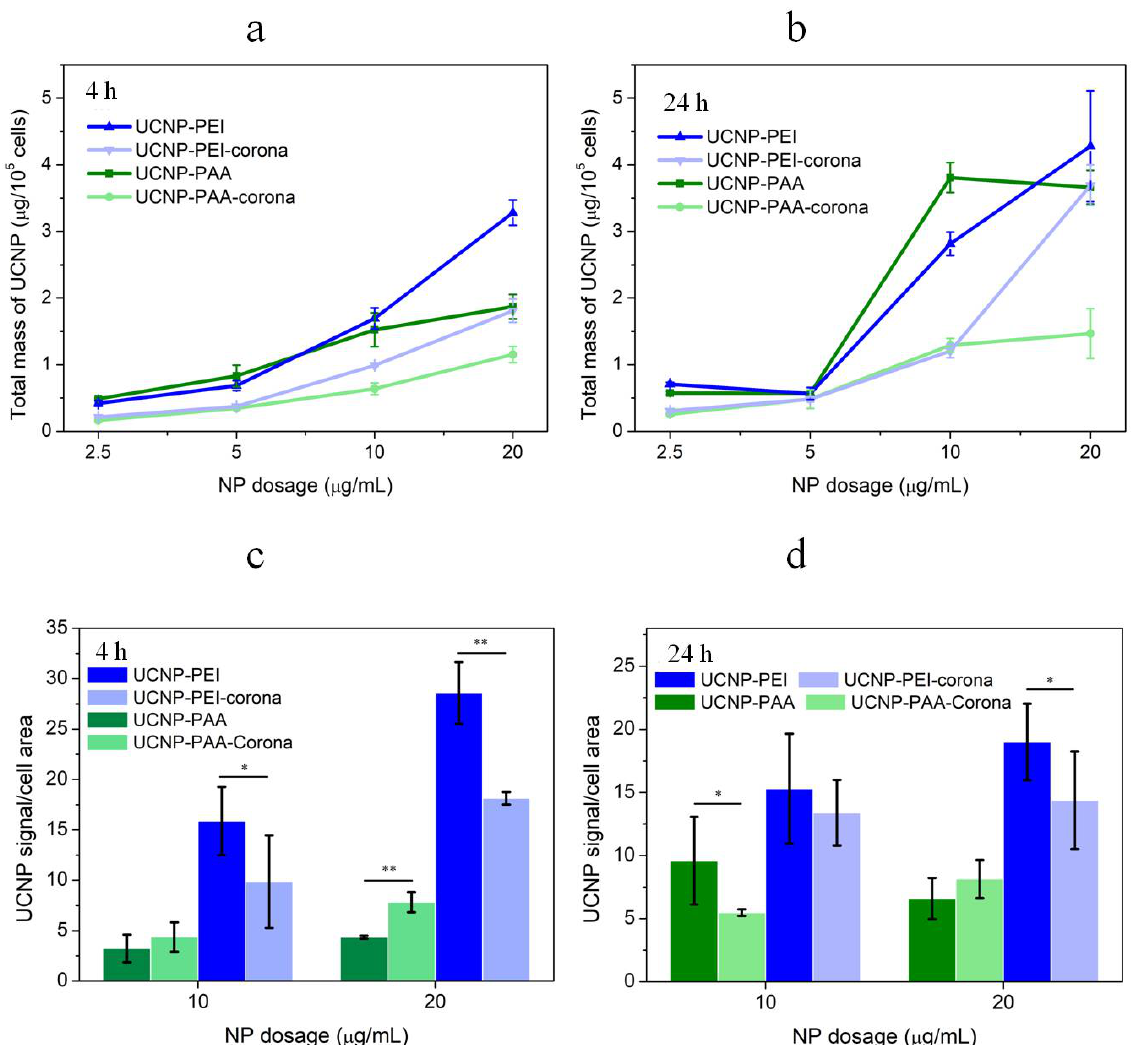
Figure 8. Average mass of UCNPs associated with MDA-MB-231 cells after 4 h ( a ) and 24 h ( b ) of incu- bation, characterised by ICP-MS (each value represents a mean of triplicate experiments ± standard deviation). Photoluminescence signal of UCNPs associated with MDA-MB-231 cells after 4 h ( c ) and 24 h ( d ) of incubation (the mean is characterised by mean photoluminescence signal intensity/cell area out of 100 cells in confocal images). * p < 0.05, ** p <